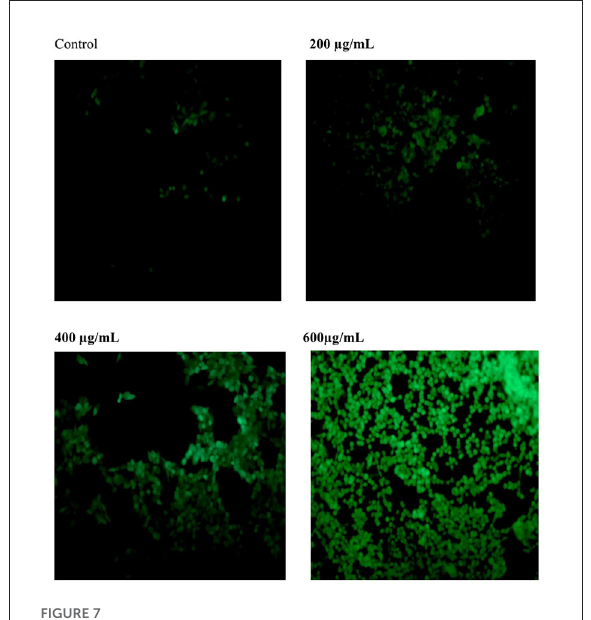
FIGURE7 Effect of SVPS2 on ROS production in HT-29